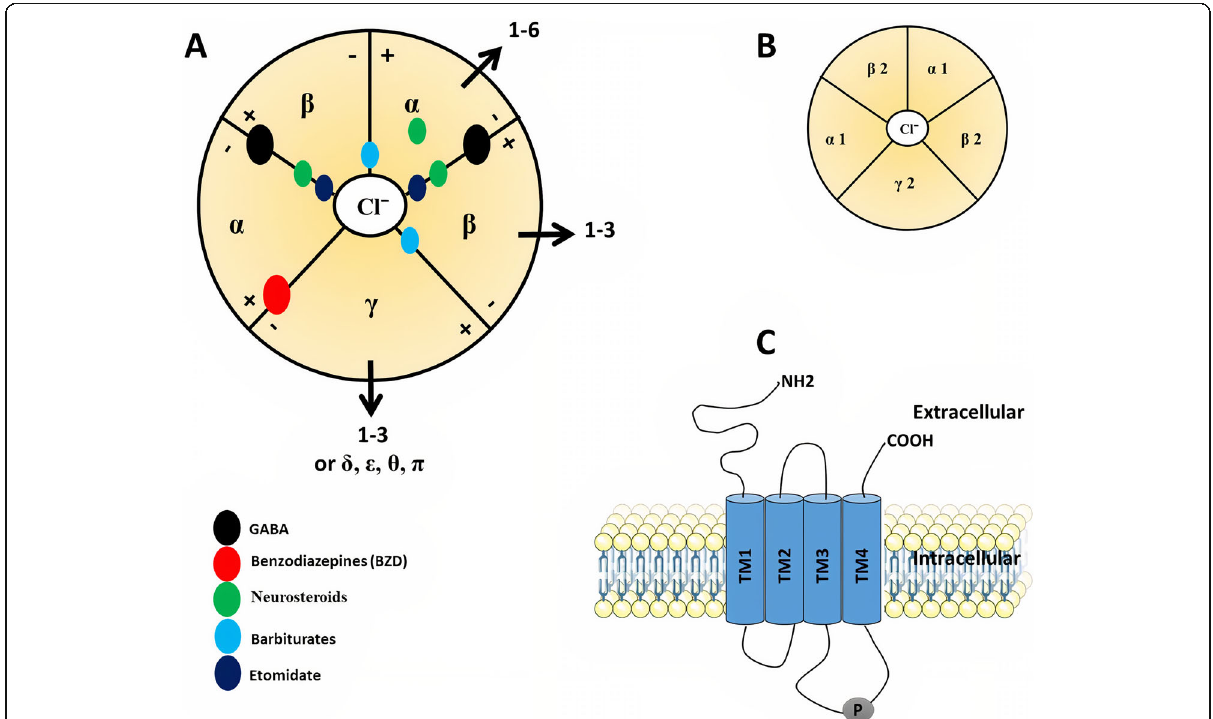
Fig. 1 Schematic representation of GABA A receptor structure. ( A ) GABA A receptors are heteropentamers that form a chloride-ion-permeable channel. They are formed by 19 subunits: α 1 – 6, β 1 – 3, γ 1 – 3, δ , ε , θ , π , and ρ 1 – 3. The GABA binding sites are located at the junction of β +/ α − , whereas benzodiazepines (BZs) are located at α +/ γ − interface. Anesthetics are located at different sites where barbiturates bind to α +/ β − , and γ +/ β − interfaces while etomidate binds to β +/ α − interface. The binding site of the neurosteroids is located at α subunit as well as the β +/ α − interface. ( B ) The most popular GABA A R isoform is composed of α 1, β 2, and γ 2 subunits arranged γ 2 β 2 α 1 β 2 α 1 counterclockwise around the central pore. ( C ) The mature subunit contains a large hydrophilic extracellular N-terminal, four hydrophobic transmembrane domains (TMD: TM1 – TM4), and a small extracellular C terminus. TM1 and TM2 are connected by a short intracellular loop while a short extracellular loop connects TM2 and TM3. Besides, TM3 and TM4 are connected by a lengthy intracellular loop that can be